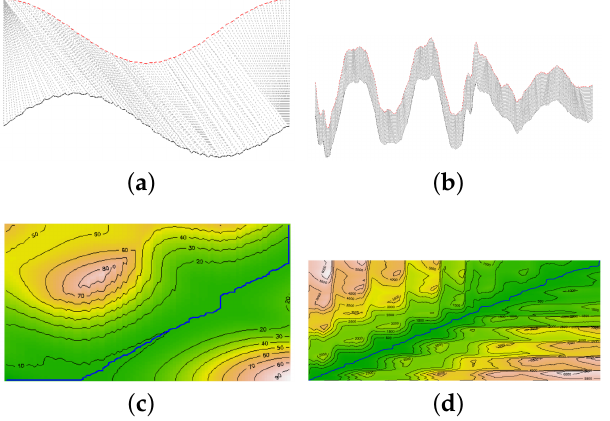
Figure 8. Illustration of a DTW process for aligning two pairs of signals (one per column). The first row: the matching between points of two pairs of signals (in red and black) is symbolized by grey lines. The second row: superimposition of the warping path on the cumulative distance matrix D. Yellow areas of D correspond to larger cumulative distances, whereas green ones correspond to smaller ones. The first case of alignment ( a , c ) is an example of speech data. The second case of alignment ( b , d ) is an example of voltage sag data. The two pairs of signals are the phase A of voltage sag data id 01 and 02, respectively.